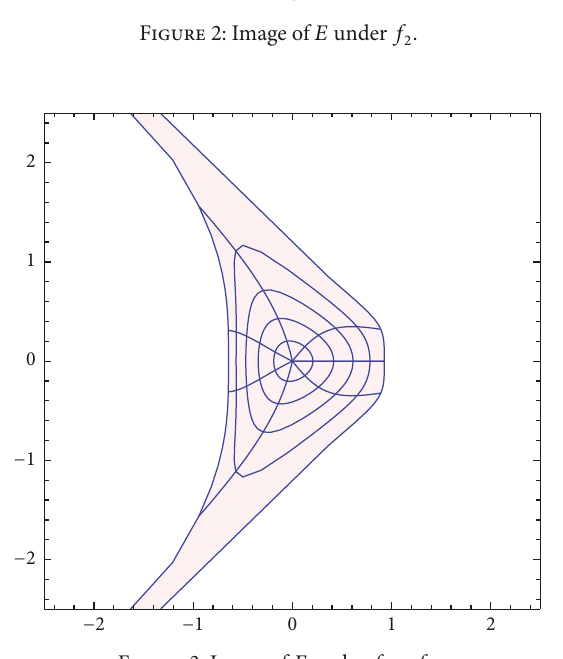
Figure 2: Image of 𝐸 under 𝑓 2 .